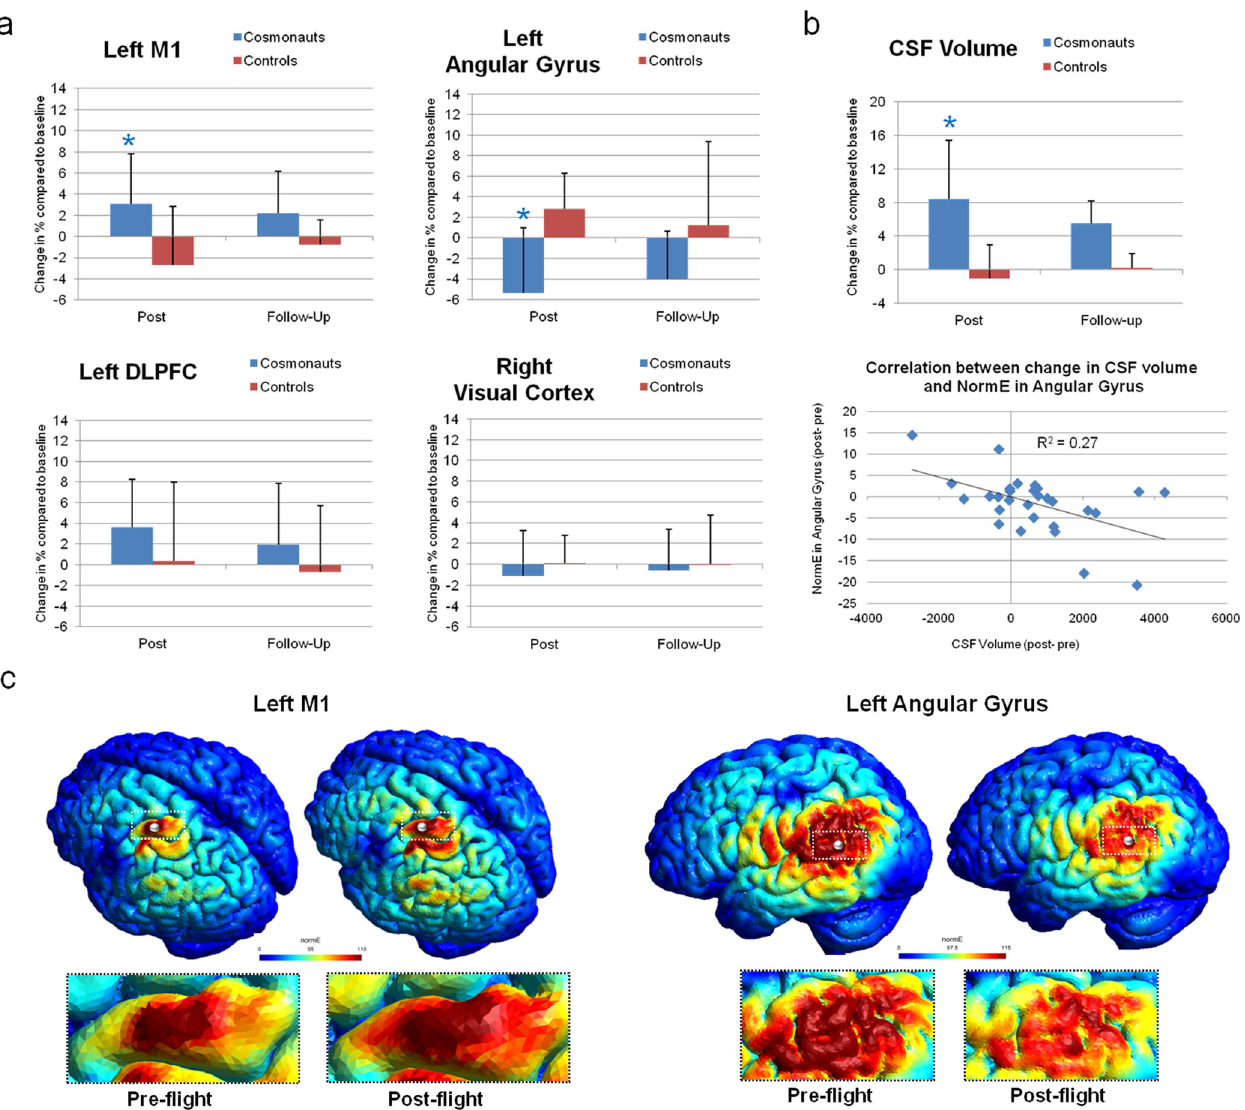
Fig. 1 Changes in NormE and brain structure in cosmonauts. a The fi gure reports changes in NormE reaching the cortical regions in cosmonauts (blue bars) compared to non- fl yer controls (red bars). Graphs show the current strength of the E- fi eld expressed in % difference of NormE from the baseline (pre- fl ight) in the target area for all cosmonauts/controls on each time-point. We found statistically signi fi cant differences in NormE under the stimulation sites in post- fl ight compared to baseline in left M1 and left angular gyrus. Asterisks indicate signi fi cant differences between cosmonauts and controls. We provided error bars for each measure. b Differences pre vs. post- fl ight in total CSF volume in cosmonauts compared to controls are also reported (left). Finally, the correlation between the change in total CSF volume and the decrease in NormE reached in the gray matter in left angular gyrus in cosmonauts is displayed ( R 2 = 0.27, p = 0.004; right). The CSF volume is presented in mm 3 ; while the NormE values are in V/m. c Below the graphs, we present pre- fl ight and post- fl ight electric fi eld maps (NormE) reaching left M1 and the left angular gyrus (presented in V/m) induced by TMS pulse in one cosmonaut. Note the difference in electric fi eld strength as represented in NormE over the interested area. The white spheres represent the cortical ROI used to extract the NormE